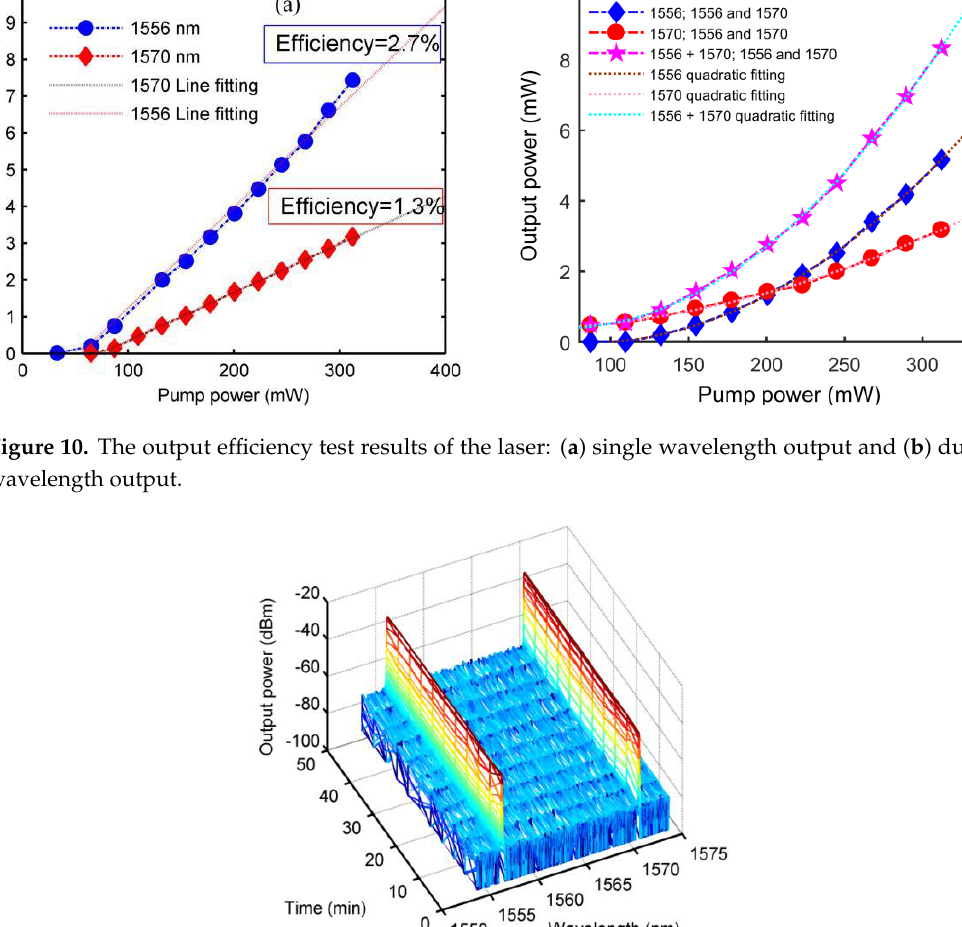
Figure 11. The stability test results of the laser.